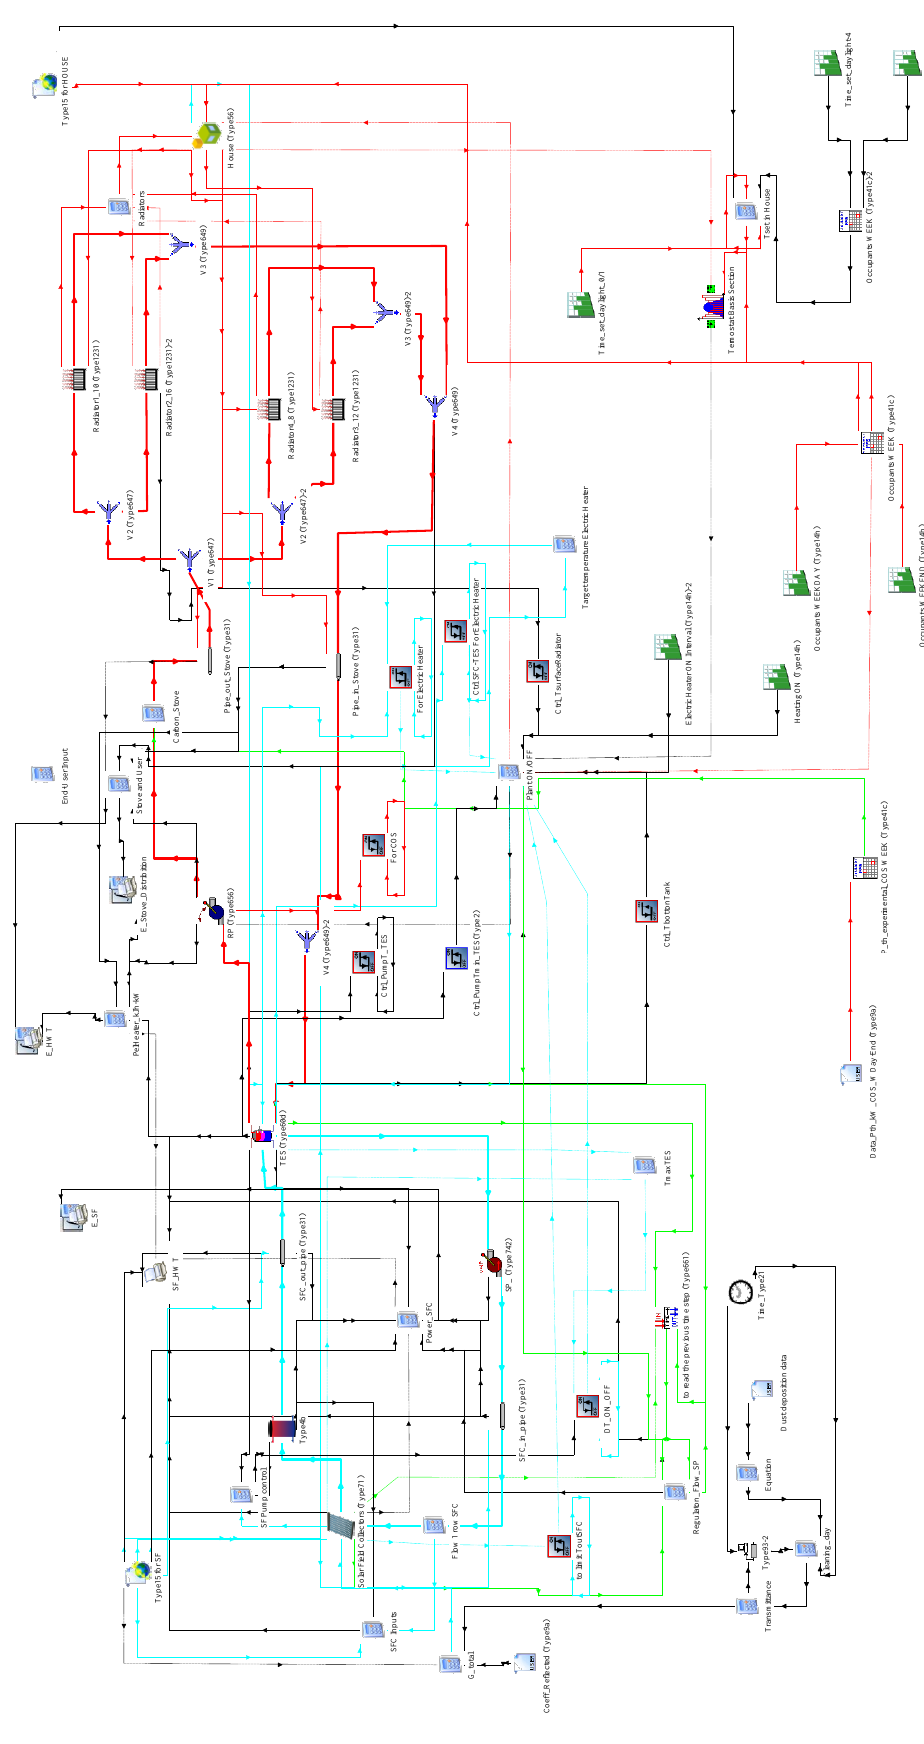
Figure 2. Scheme of the TRNSYS project.